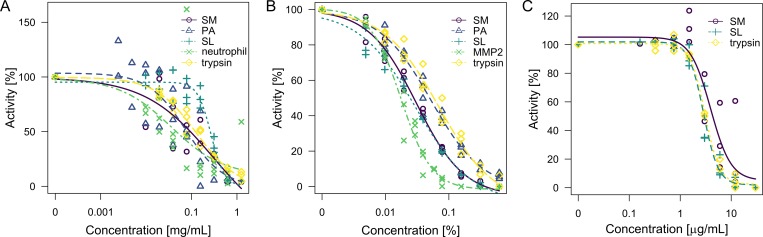
Activity of bacterial proteases with antimicrobials in fluorogenic assay.Pure proteases (MMP-2 or trypsin) or single-source proteases from bacterial or eukaryotic media were evaluated in fluorogenic assay with quenched gelatin as a substrate. Reactions were in the presence or absence of different concentrations of silver lactate (A), chlorhexidine digluconate (B), and octenidine hydrochloride (C). Differences in fluorescence increase were related to control without antiseptics. Measurements were repeated two to three times. X-axis is in log10 scale. PA–P. aeruginosa, SL–S. liquefaciens, SM—S. marcescens.